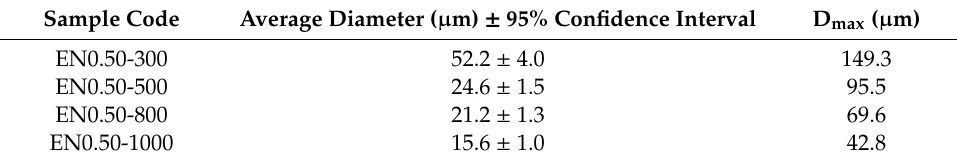
Table 4. E ff ect of mixing speed on average and maximum microcapsule diameters at 0.5 wt % CNT